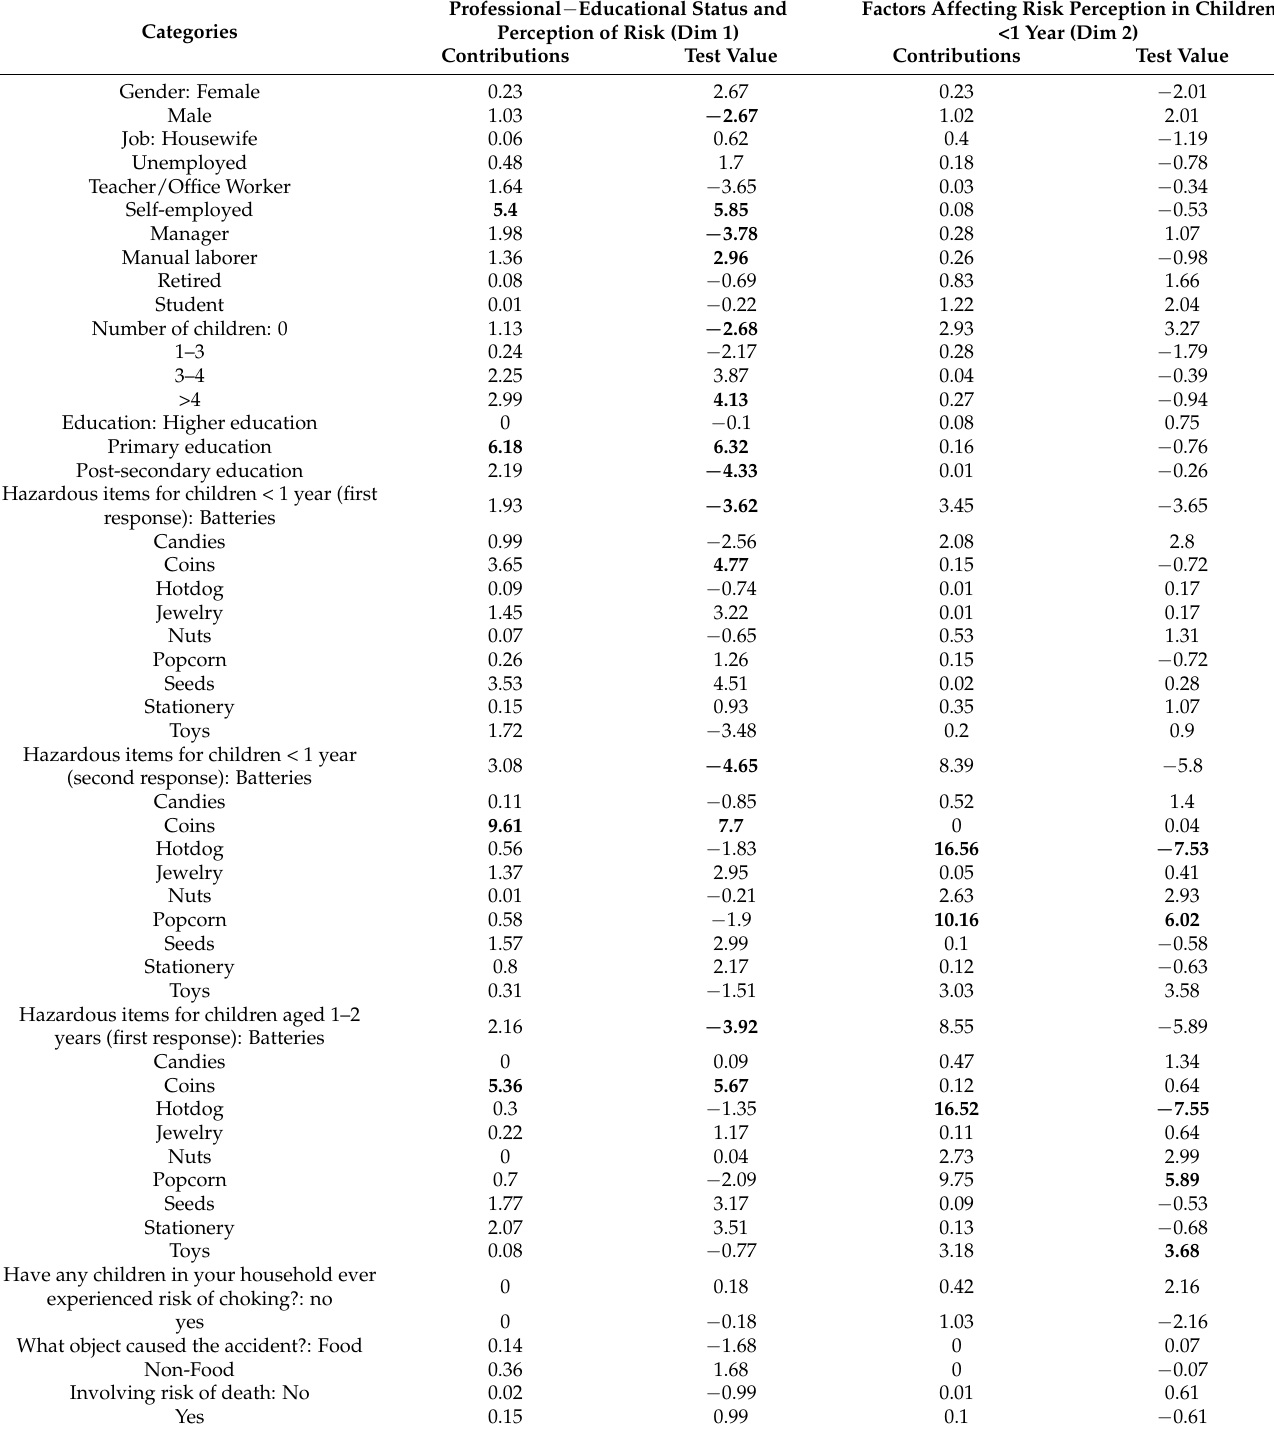
Table 2. Contribution (percentage) and test values (standardized coordinates) of variables’ levels for each of the two dimensions. In bold, the most important contributors are defined as variables’ levels with a greater percentage of explained data variance. In bold are also reported the greater test values (absolute values) on both positive and negative sides of the axes. The medians of coordinates of factors contributing to each dimension are for “Professional-educational status and perception of Risk” (Dim 1): 0.83 (Brazil) and − 0.24 (Italy); for “Factors affecting Risk perception in children <1 year” (Dim 2): 0.01 (Brazil) and 0.07